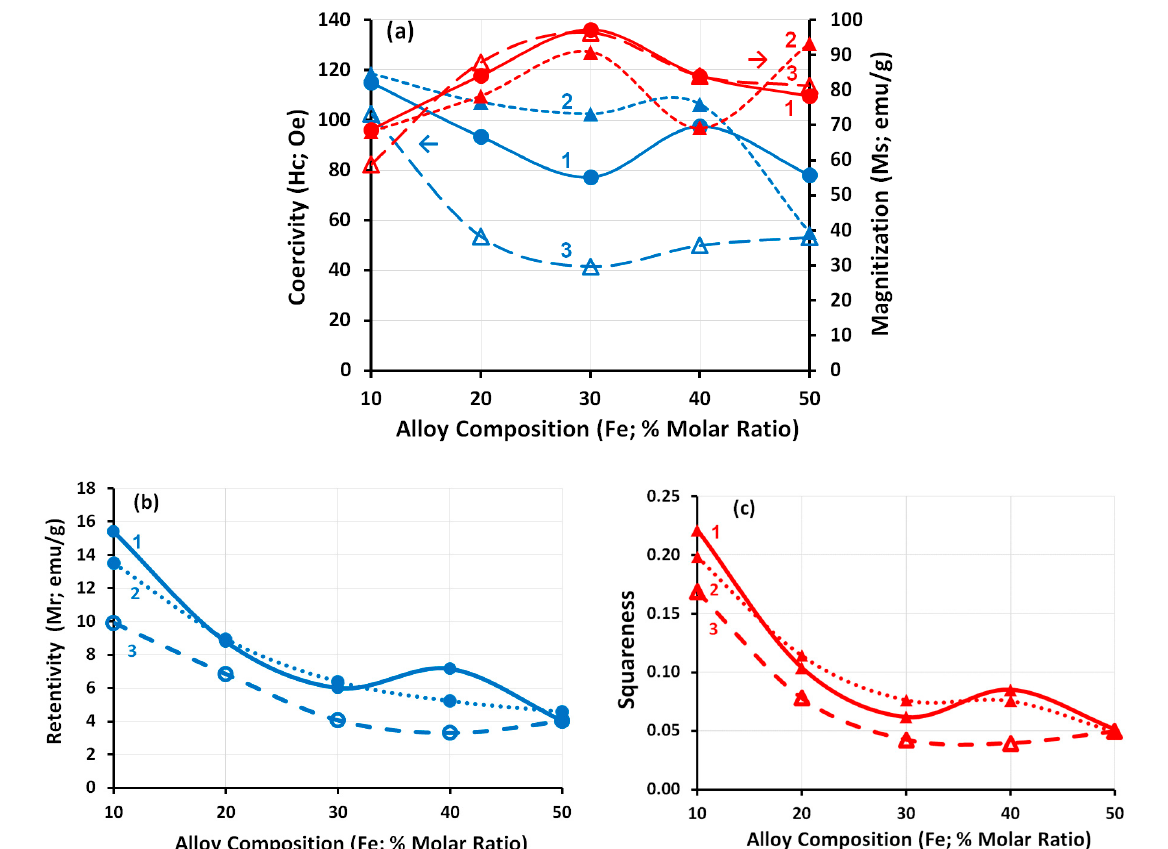
Figure 11. Magnetic Properties as function of Iron molar ratio in the alloys; ( a ) Coercivity and Magnetization, ( b ) Retentivity, and ( c ) Squareness. Reference conditions: Curve 1: 0.1 M metal concentration in 40 mL reaction volume, Curve 2: 0.1 M metal concentration in 80 mL reaction volume, and Curve 3: 0.3 M metal concentration in 80 mL reaction solution.